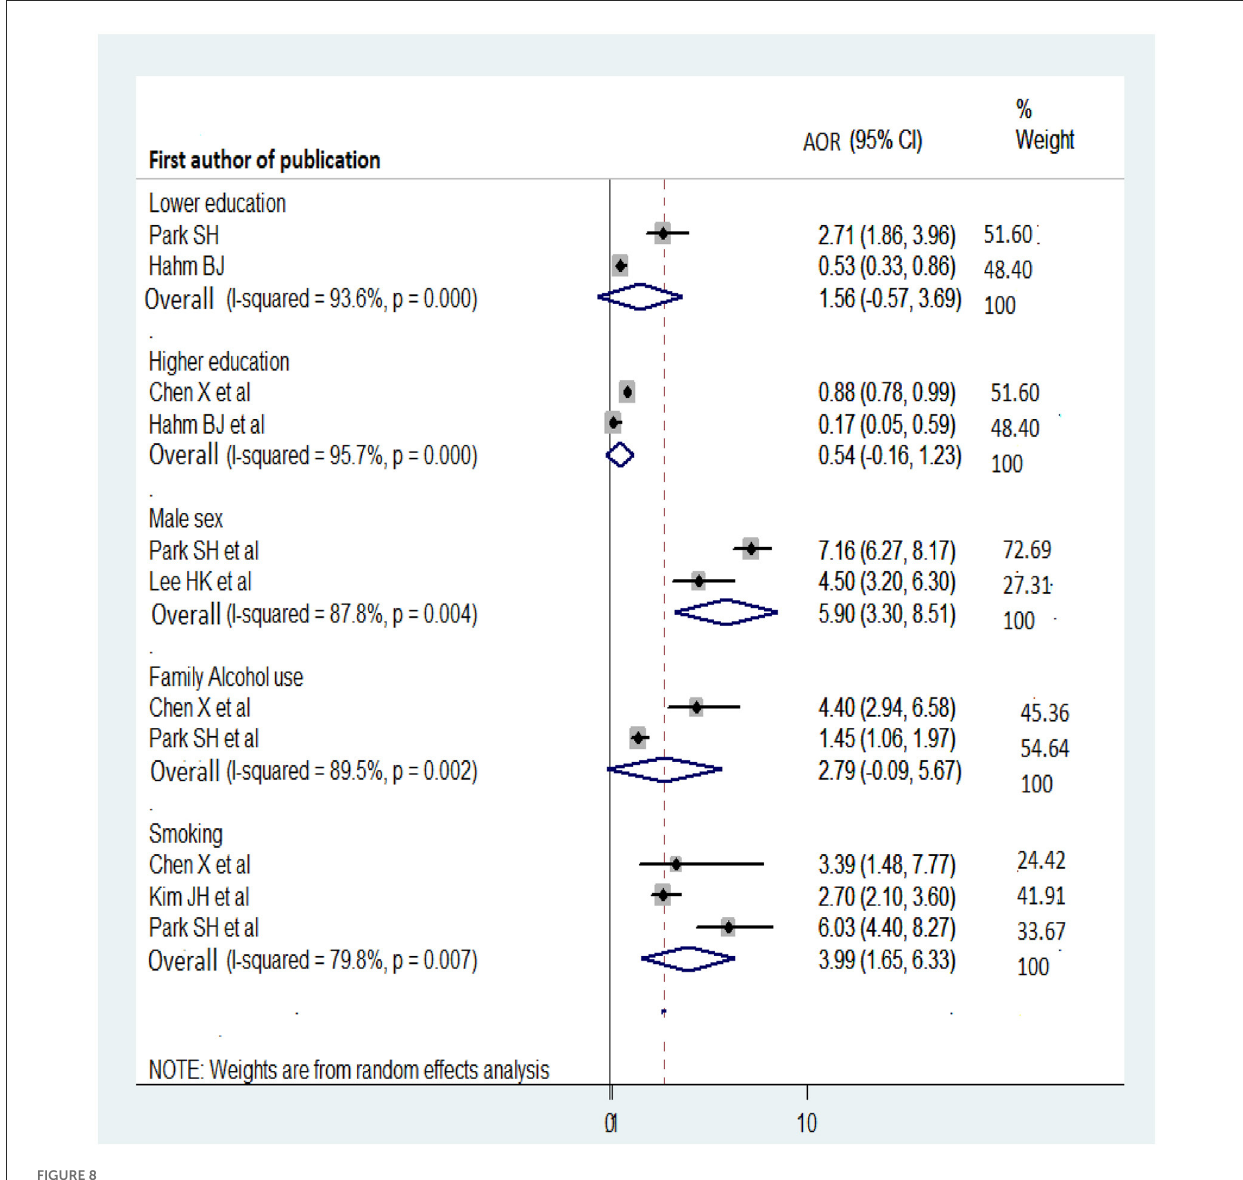
FIGURE8 Forest plot for the determinants of